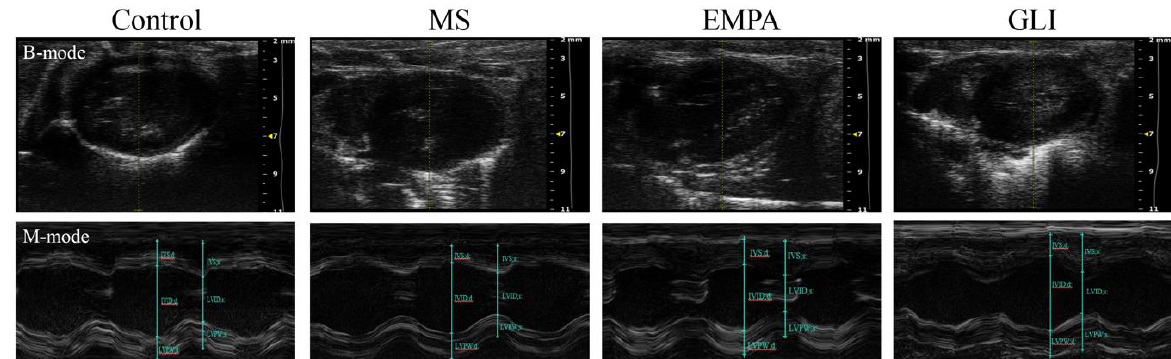
Figure 1. B-mode and M-mode images for the measurement of the dimensions of interventricular septal thickness at end-diastole (IVSd), left ventricular internal diameter at end-diastole (LVIDd), left ventricular posterior wall thickness at end-diastole (LVPWd), interventricular septal thickness at end-systole (IVSs), left ventricular diameter at end-systole (LVIDs), and left ventricular posterior wall thickness at end-systole (LVPWs) among the study groups ( n = 5 for each group).